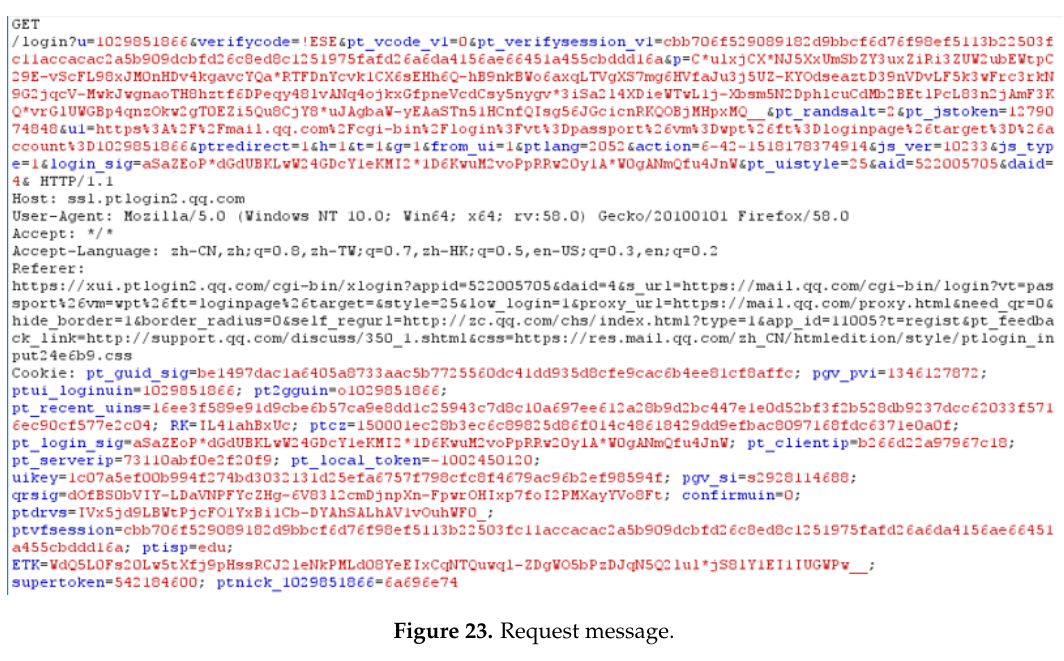
Figure 23. Request message. Appl. Sci. 2018 , 8 , x FOR PEER REVIEW